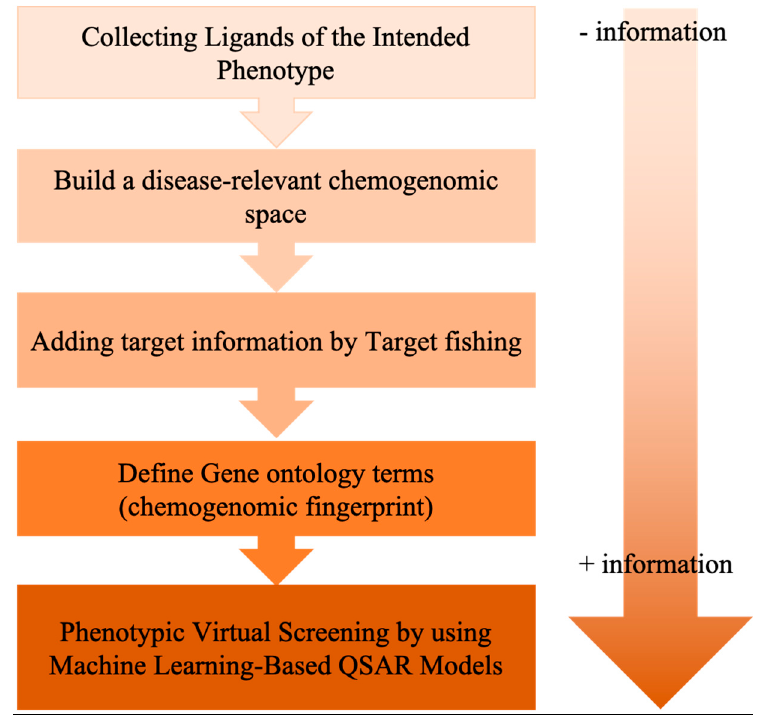
Figure 9. Schematic representation of systemic chemogenomics/quantitative structure-activity relationships (QSARs) for phenotypic VS.